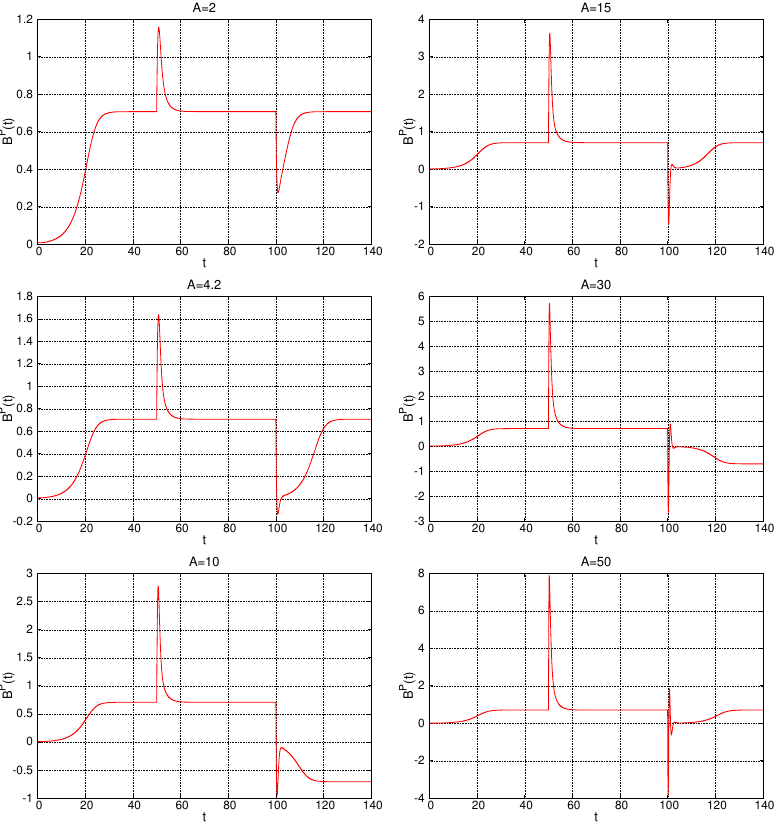
We see that for the small pulses the poloidal component does not change the sign ( A = 2); B P (t) changes the sign for a short time and returns to its original value ( A = 4 . 2).